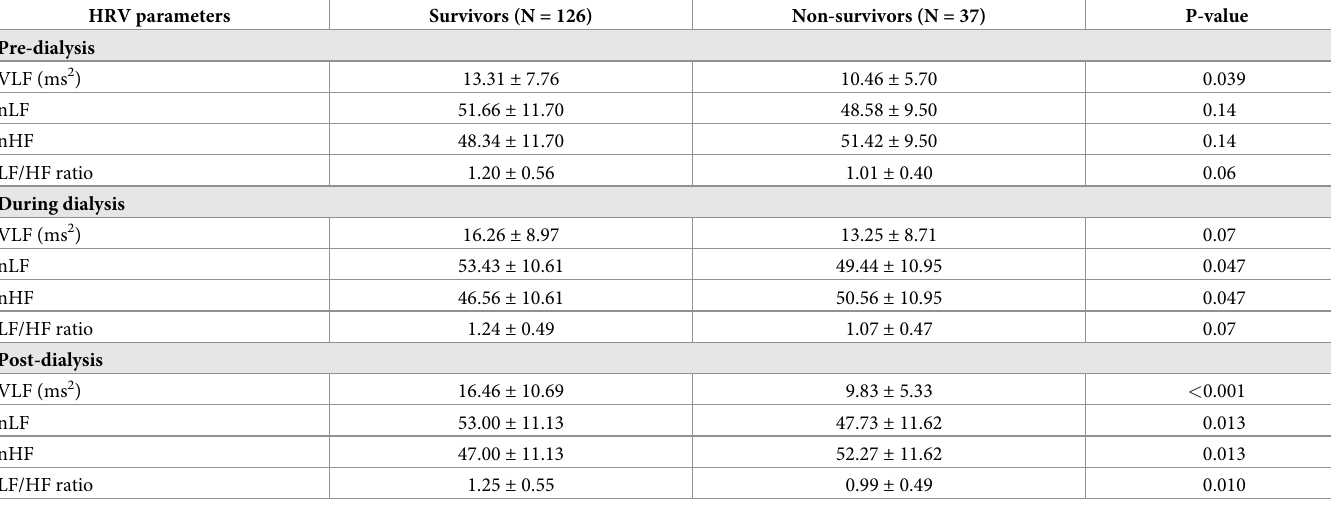
Table 2. Comparison of heart rate variability (HRV) parameters between survivors and non-survivors. HRV